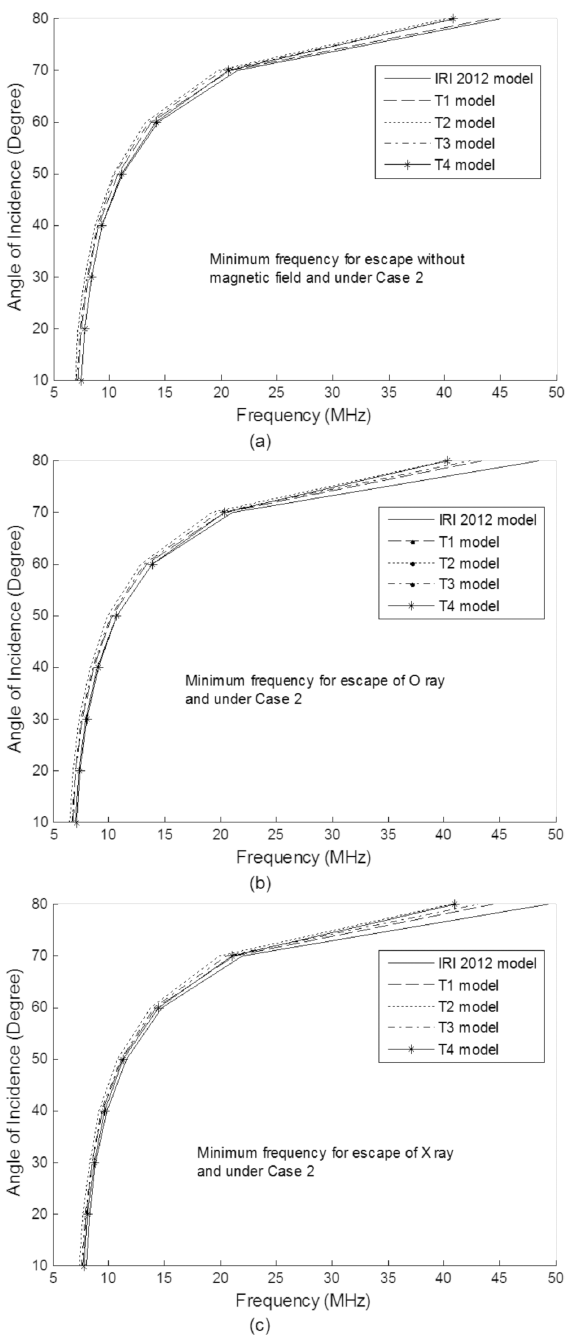
Figure 10. Variation of minimum frequency for escape with angle of incidence under Case 2 for: (a) without influence of magnetic field, (b) for O mode under influence of magnetic field, (c) for X mode under influence of magnetic